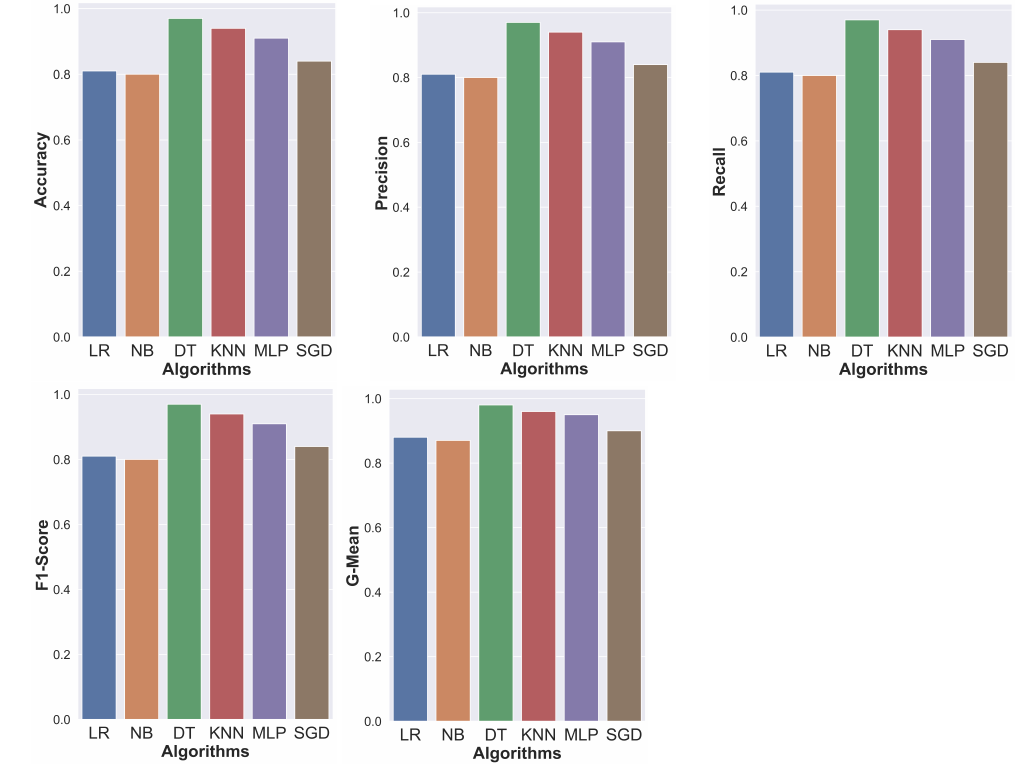
Figure 7. Score values of the various measures for Udacity